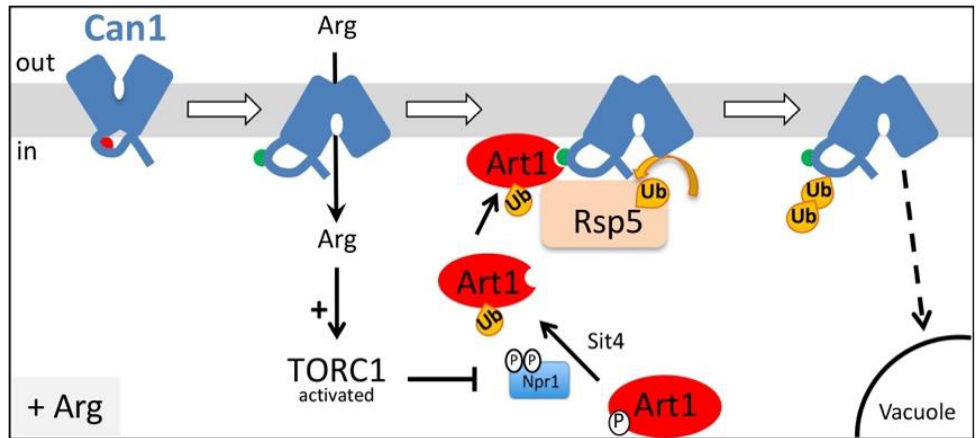
Figure 1. Model for Art1-dependent Can1 endocytosis in response to Arg transport. In the absence of substrate, Can1 is mostly found in an outward-facing conformation and this structures the N- terminal tail in a way that masks the binding site for Art1 (aa 70 – 81, red hemicycle). Once Arg is added in the medium, a transient shift of the permease to an inward-facing conformation of the transport cycle repositions the N-terminal tail and exposes the binding site for Art1 (now green hemicycle). Arg uptake also stimulates TORC1, leading to inactivation of Npr1, and activation of Art1 via de-phosphorylation. Activated Art1 can then recognize the exposed binding site at the N- tail of Can1, resulting in Rsp5-mediated ubiquitylation of Can1, endocytosis and sorting to the vac- uole for degradation.